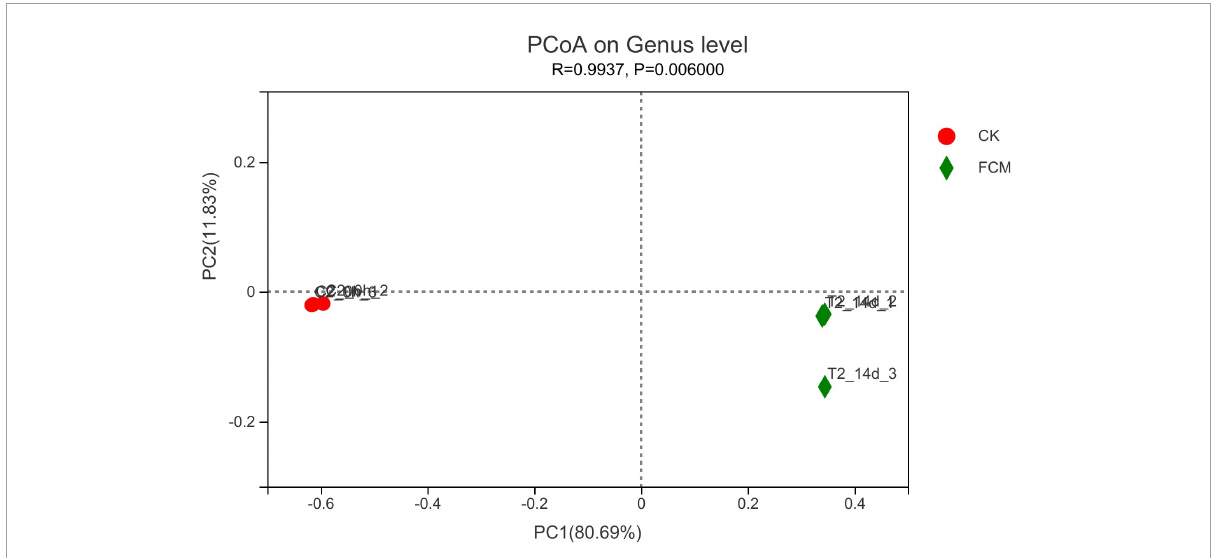
FIGURE9 Principal coordinate analysis (PCoA) analysis at genus level. In each sample name, CK and fermented cottonseed meal (FCM) represent the sample from CM and FCM, respectively. Points with the same pattern represent the three replicate samples from the same